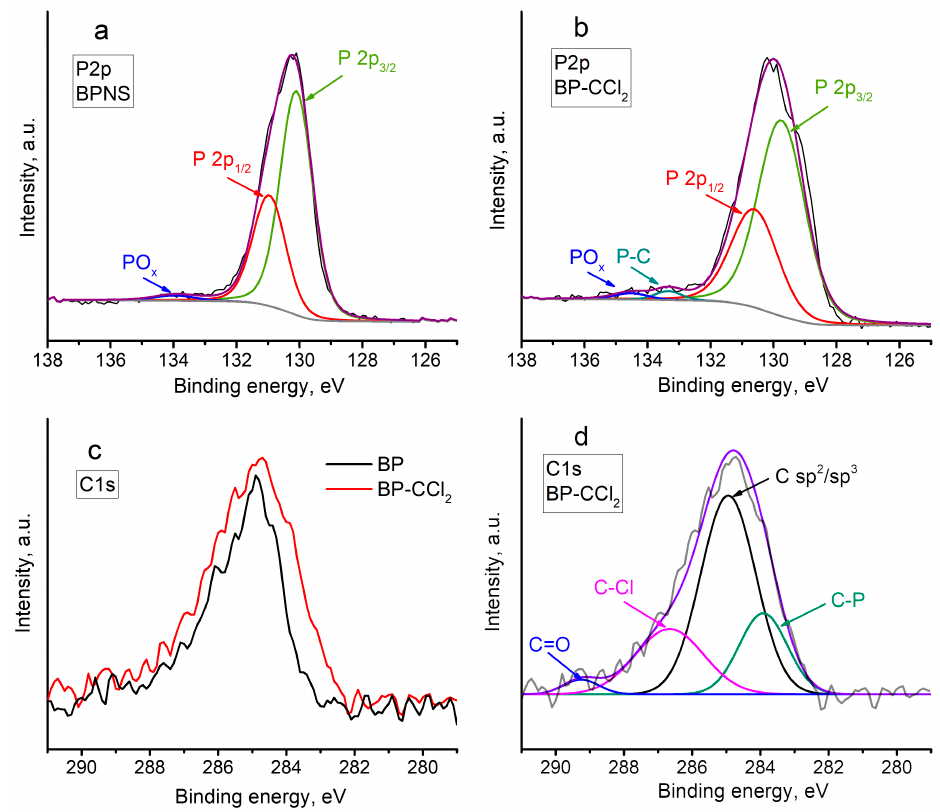
Figure 5. P 2p high-resolution XPS spectra of BPNS ( a ) and BP–CCl 2 ( b ). Experimental spectra, fitting lines and background lines are shown as black, purple, and gray lines, respectively. ( c ) The comparison of the C 1s high-resolution XPS spectra of BPNS and BP–CCl 2 . ( d ) C 1s high-resolution XPS spectrum of BP–CCl 2 . Experimental spectrum and fitting line are shown as black and violet lines, respectively.